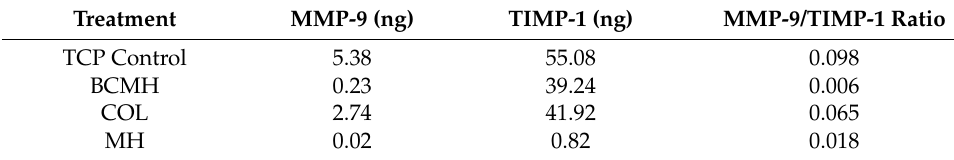
Table 1. MMP-9 and TIMP-1 levels and corresponding